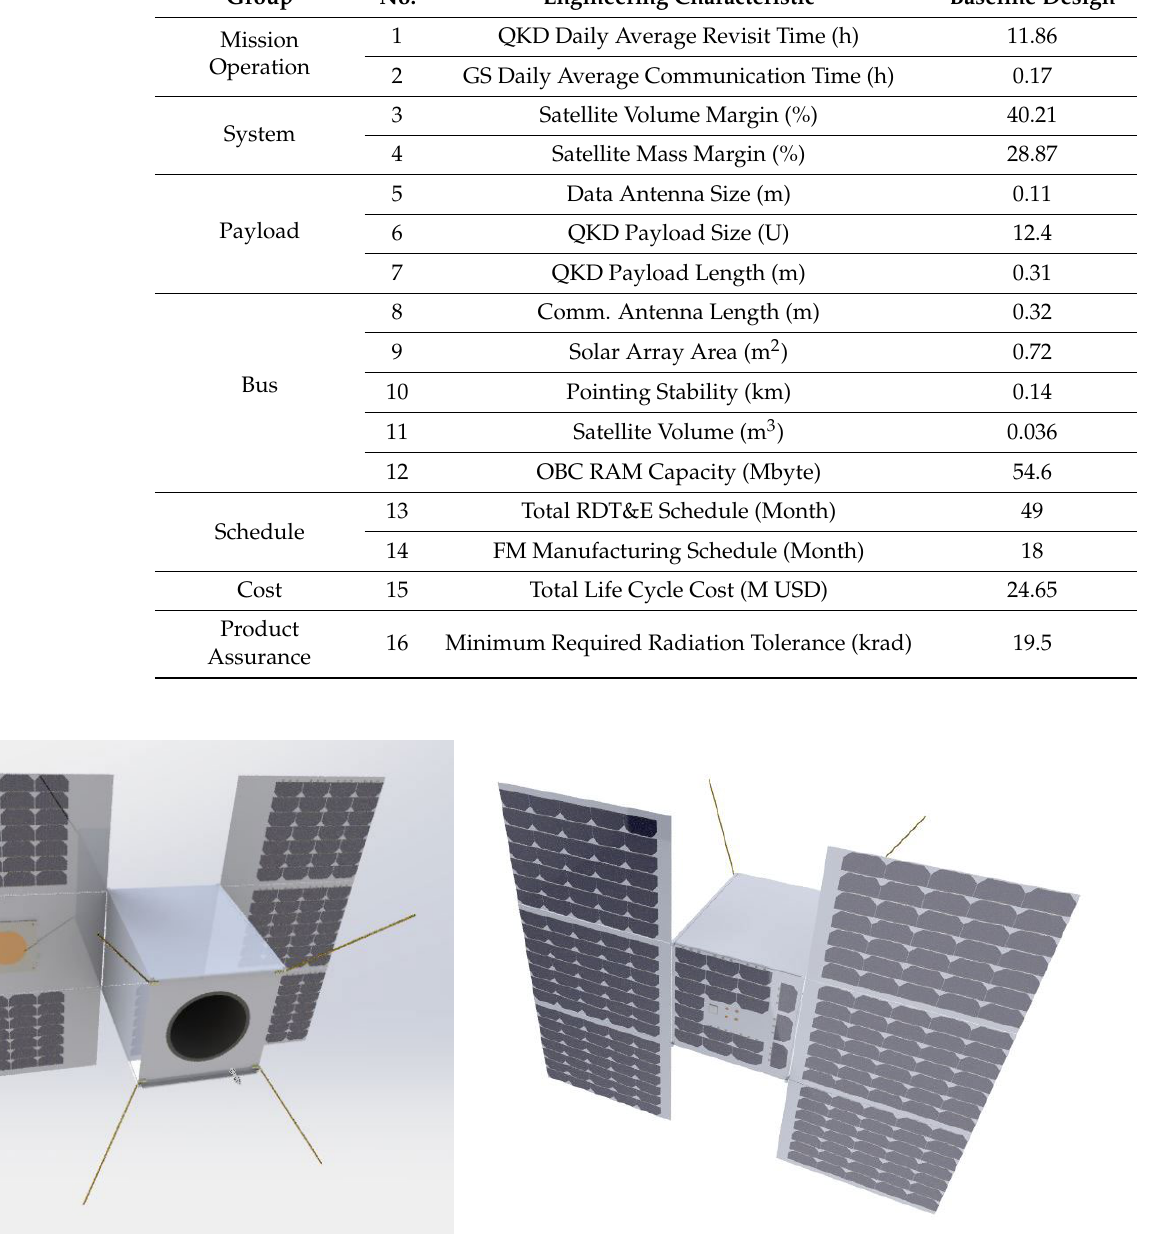
Figure 10. Parametric study of QKD optic size. In some cases, the requirements for specific ECs may not be satisfied by the constraint of the QKD optic size of 0.1 m or less. One can refer to Table 8 to choose other system drivers affecting the violated ECs and perform the parametric study again with the chosen drivers to satisfy them. If specific ECs are still not met through parametric studies, wider design space, a trade-off for those requirements, or new technology infusion may be re- quired. Here, it is emphasized that the design revision to meet the constraints inside the design space should be conducted near the system-level baseline design obtained through the mission-oriented design process.